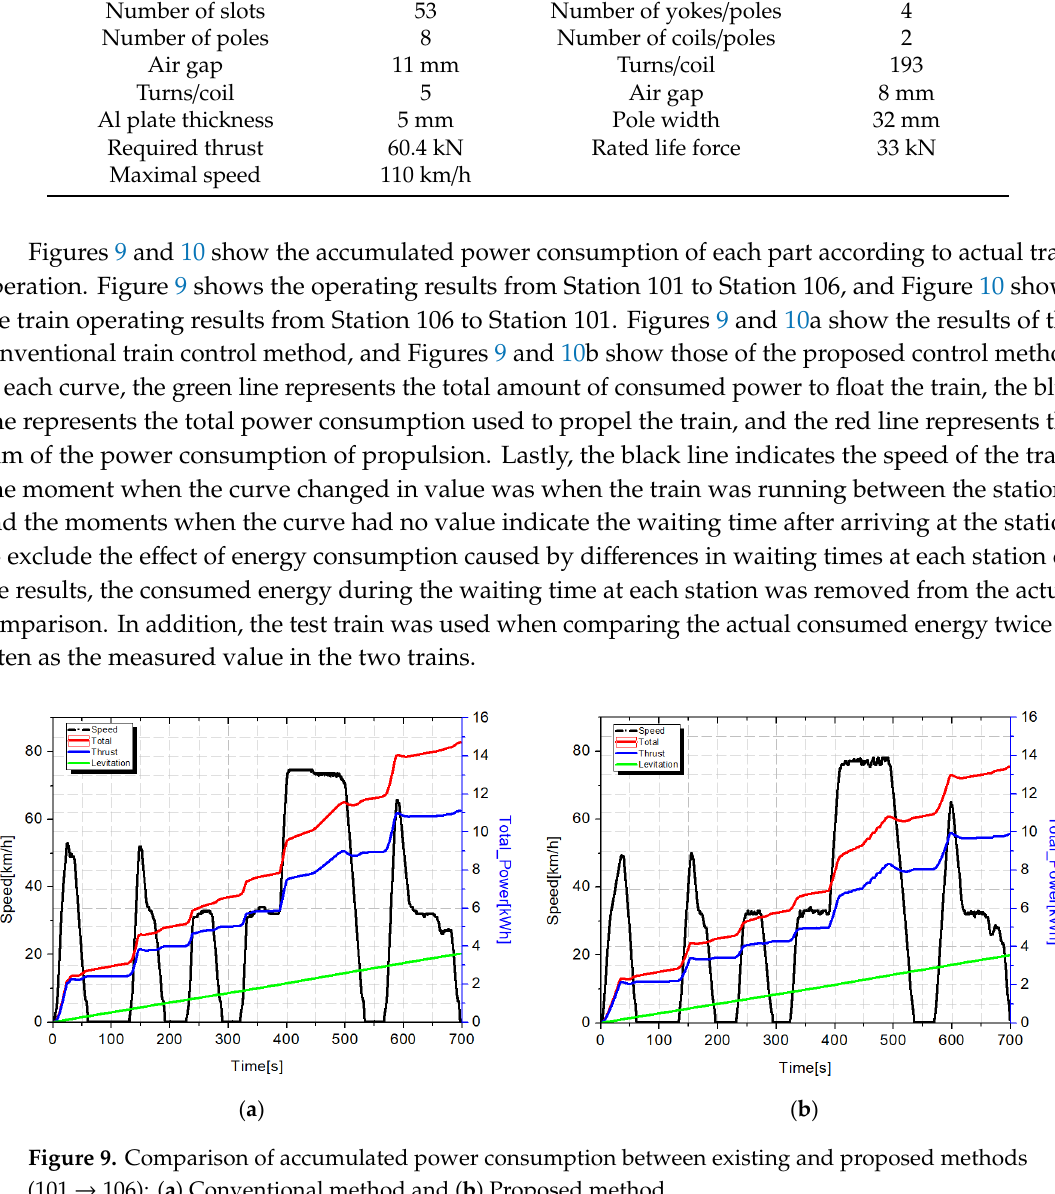
Figure 10. Comparison of accumulated power consumption of existing and proposed methods (106 → 101): ( a ) Conventional method and ( b ) Proposed method